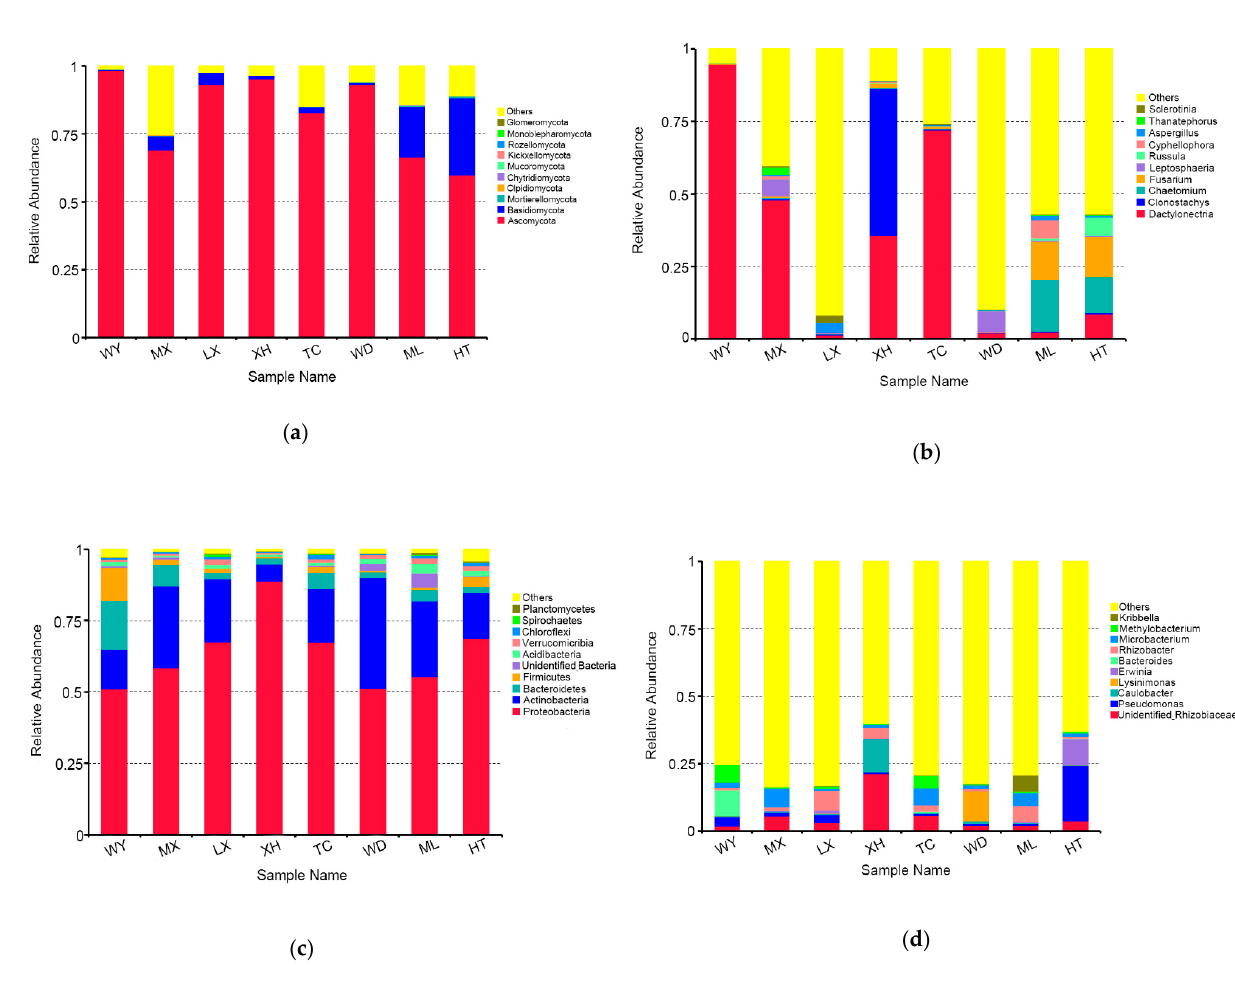
Figure 3. Relative abundances of the endophytic fungi at the phylum level ( a ), endophytic fungi at the genus level ( b ), endophytic bacteria at the phylum level ( c ), endophytic bacteria at the genus level ( d ) for each sample. Relative abundances are based on the proportional frequencies of the DNA sequences that could be classified. “Other” represents the total of relative abundance outside the top ten maximum relative abundance levels.